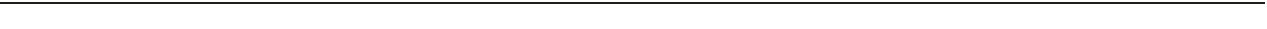
Fig. 5 Sequence diversity in New World arenavirus GP1s. a Overlay of ribbon diagrams of JUNV GP1 (red, PDB: 5EN2 14 ) and MACV GP1 (gray, PDB: 3KAS 13 ). N-linked glycans are shown as sticks. Asterisks indicate N-linked glycans that differ in position between JUNV and MACV. Green spheres are sites of substitutions between the JUNV MC2 strain and Candid #1, the live attenuated vaccine strain. Loop 10 is a disul fi de-linked insert that is unique to MACV. Disul fi de bridges are shown as yellow sticks. b Sequence alignment of New World arenavirus GP1s. Antibody and TfR1 contacts are indicated. Substitutions in Candid #1 (with respect to JUNV MC2) are highlighted in green. Tree diagrams indicate predicted sites of N-linked glycosylation for JUNV GP1. The fi gure was generated using ESPrit3 64 and modi fi ed. GenBank accession numbers used for sequences used for the alignment are JUNV (MC2, D10072), JUNV (Candid #1, ACY70854.1), MACV (Carvallo, NC_005078), GTOV (INH-95551, NC_005077), CHPV (810419, YP_001816782.1), and SBAV (SPH114202, NC_006317). The sequence of TCRV shown in the alignment is that of the pseudotype used in this study and other studies, 14, 30 which has a deletion spanning amino acid residues 121 – 132 and three substitutions (I134A, G418S and E458R) compared to GenBank NC_004293. c Surface representation of JUNV GP1 (PDB: 5EN2) 14 showing conservation based on the alignment with MACV GP1 shown in b generated with ESPrit3. 64 Dashed circle indicates the location of the Tyr211 TfR1 pocket. d Surface representation of JUNV GP1 (PDB: 5EN2) 14 showing sequence conservation with MACV, GTOV, CHPV, SBAV as shown in b . Using the algorithm available in ESPrit3, 64 residues with a similarity global score lower than 0.7 are in white, and residues with a similarity global score in the range 0.7 – 1.0 are color-ramped in shades of red (with dark red showing the greatest